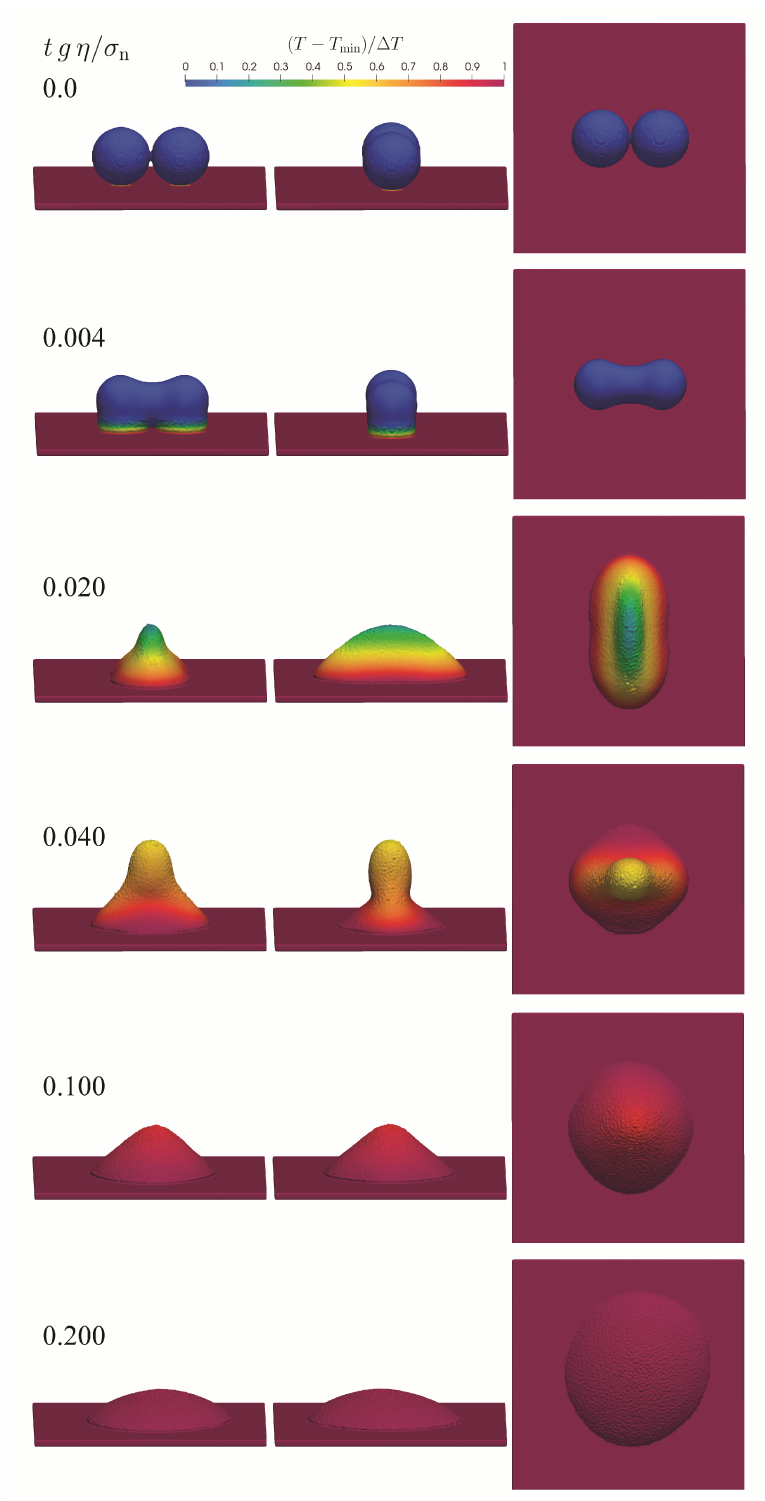
Figure 26. Coalescence of two droplets under the influences of temperature-dependent viscosity and surface